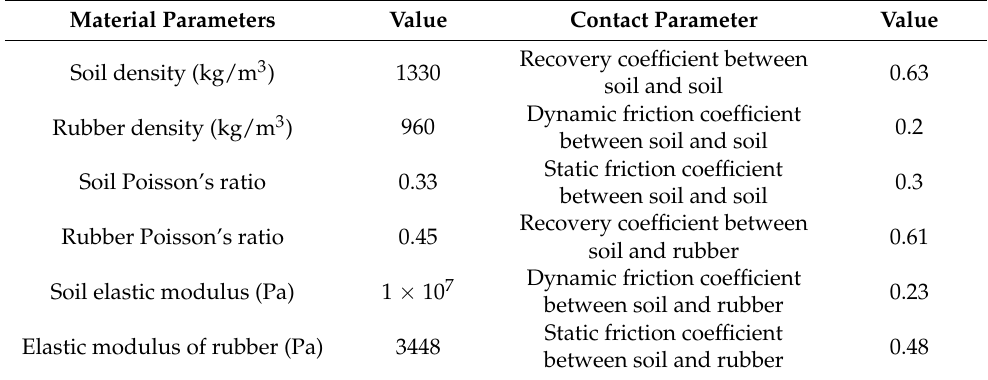
Table 6. Basic parameters for the soil particles and geometry in the discrete element